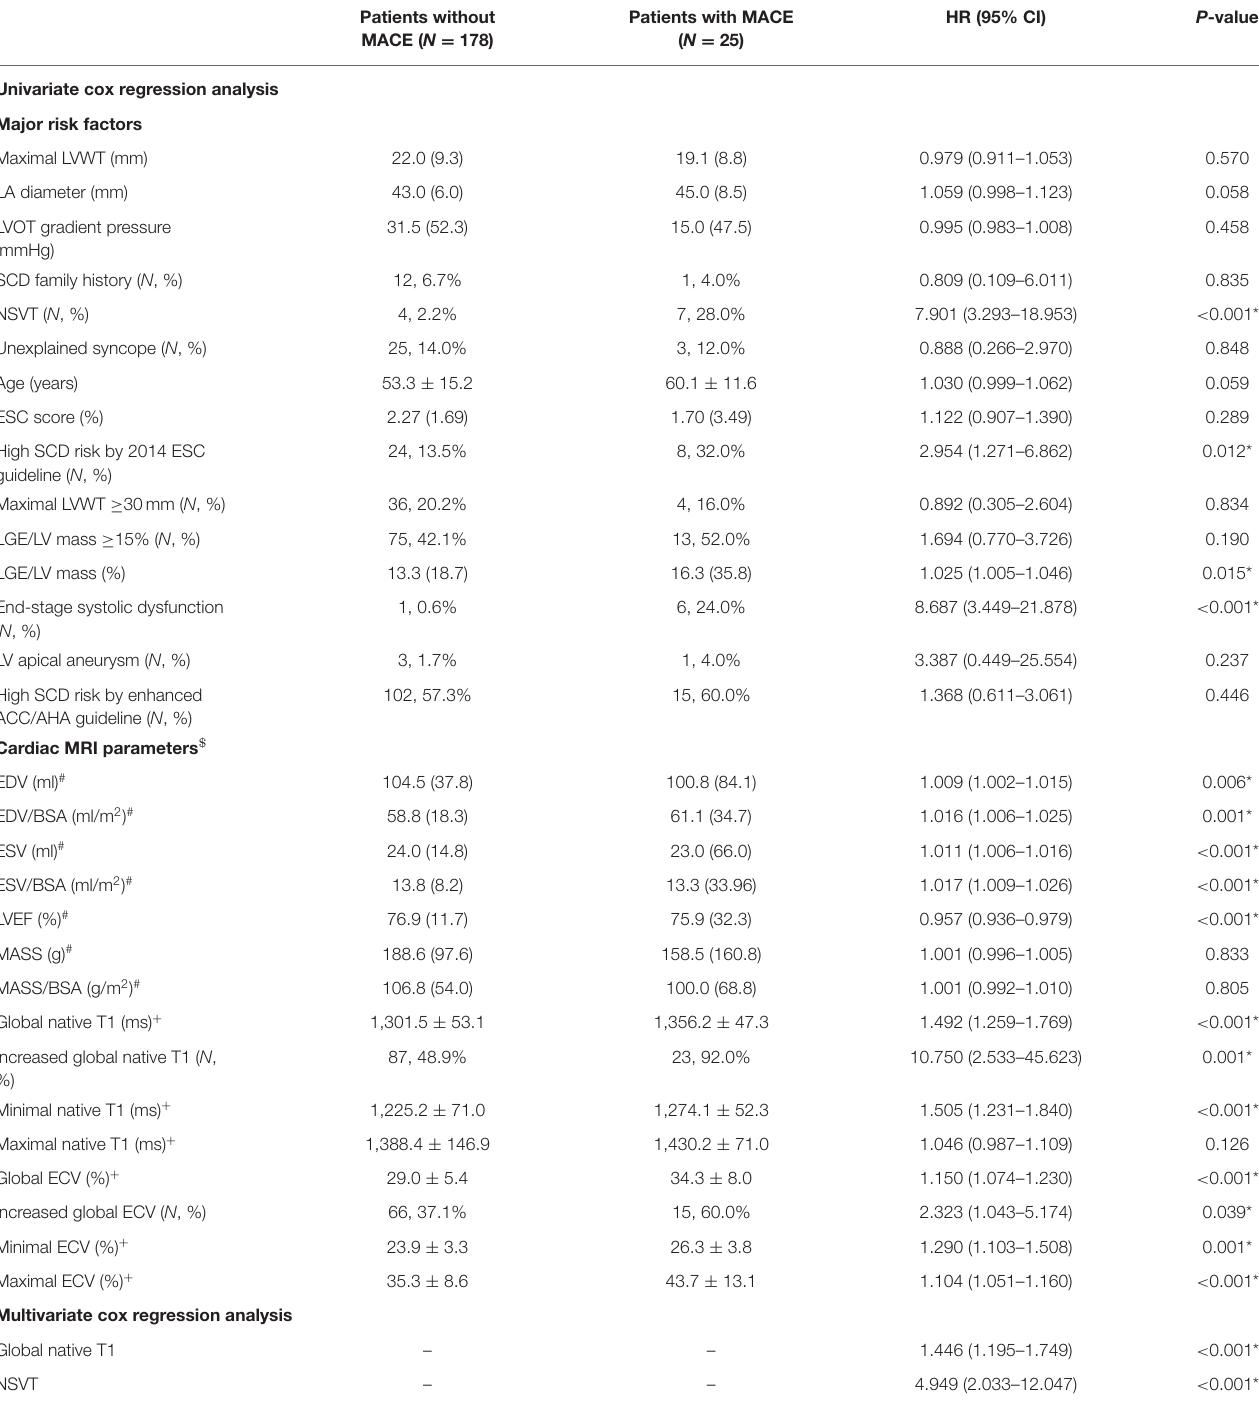
Patients without Patients with MACE HR (95% CI) P -value MACE ( N = 178) ( N = 25)